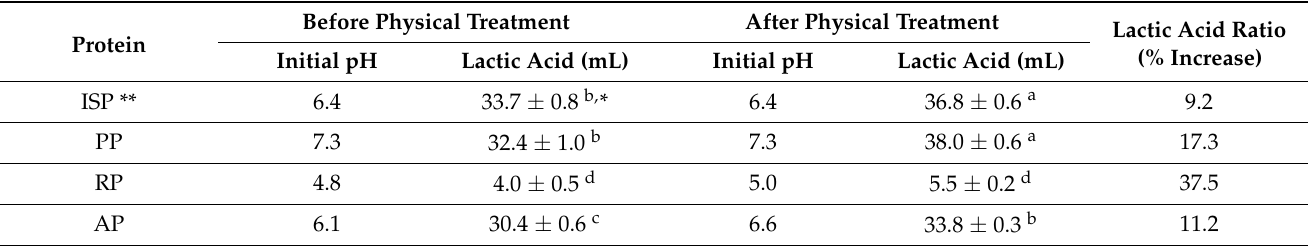
Table 1. Initial pH and 1 N lactic acid titration amounts to pH 3.0 of various vegetable protein solutions (5%, w / w ) before and after the physical treatment (homogenization and pasteurization). Before Physical Treatment After Physical Protein